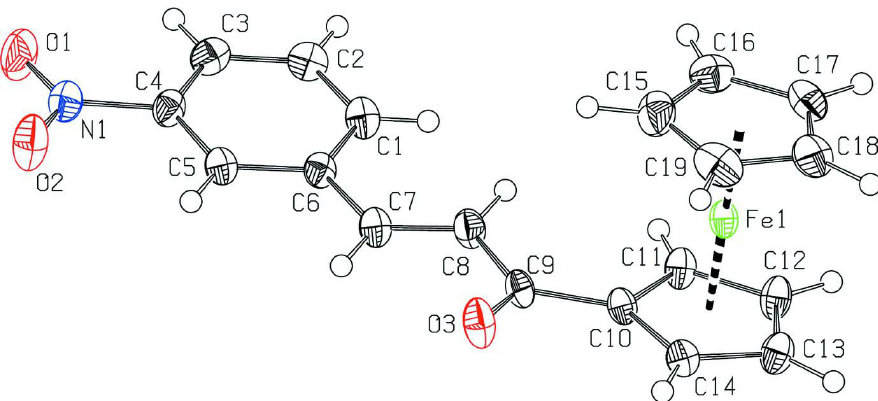
Figure 1 The molecular structure of the title compound, showing 50% probability displacement ellipsoids.